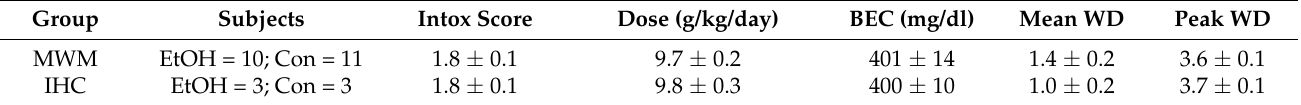
Table 3. Binge parameters for immunohistochemistry (IHC) versus MWM cohorts.